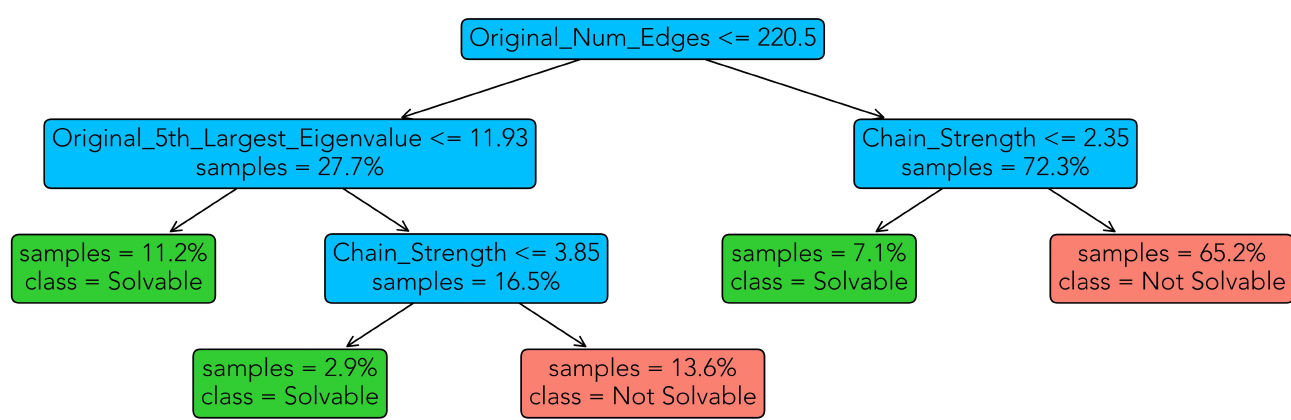
Figure 4. Decision tree for classification of MC instances into solvable and unsolvable, using the features outlined in Section 2. Setting of random annealing time and random UTC prefactor. Left branches denote true bifurcations, right branches denote false bifurcations. Green leaves are solvable cases, red leaves are unsolvable cases, and inner nodes are colored in blue.